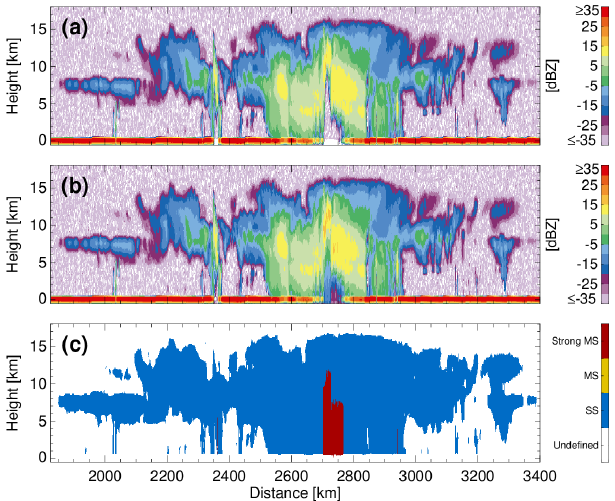
Figure 4. The C-NOM reflectivity simulations for (a) single and (b) multiple scattering and (c) the C-FMR multiple-scattering de- tection mask where SS stands for single scattering and MS for mul- tiple